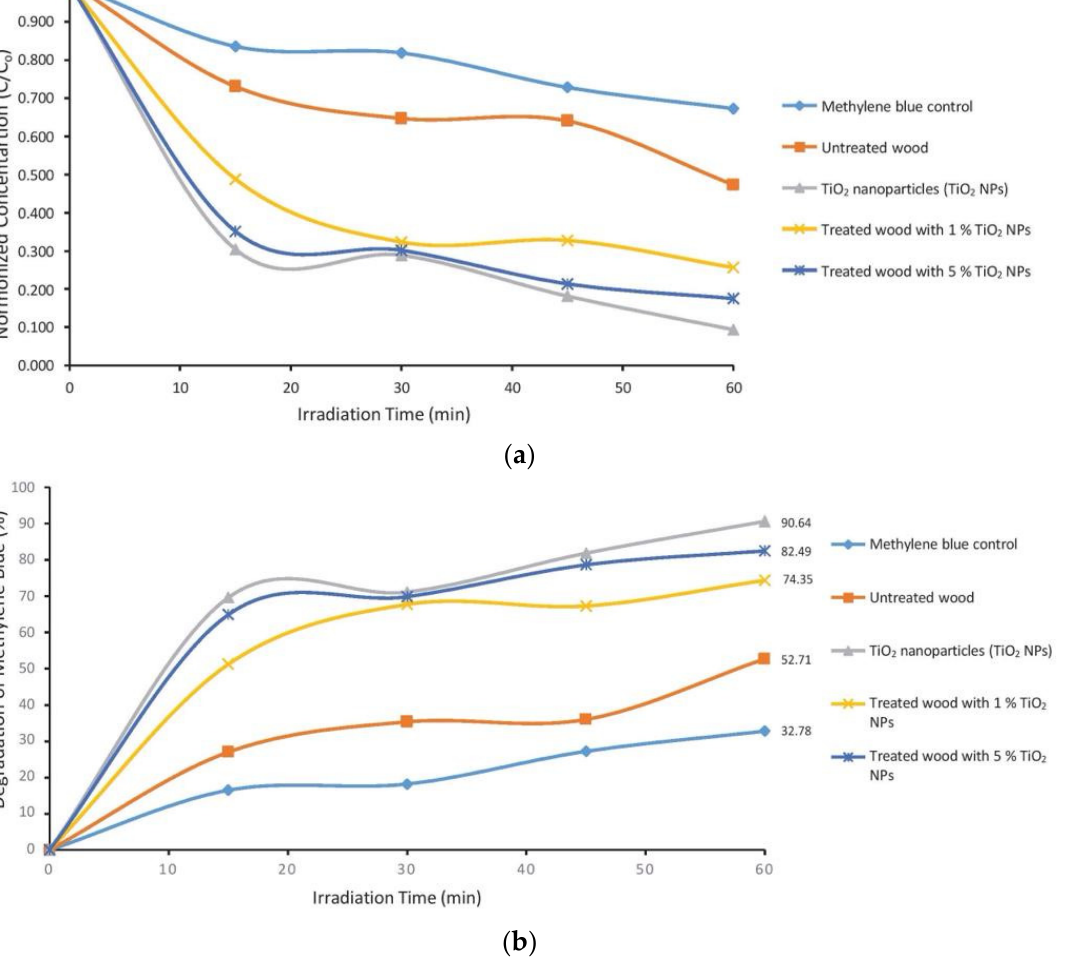
Figure 8. Curves ( a ) relative concentration of C/C o and ( b ) percentage of degradation of methylene blue compounds.